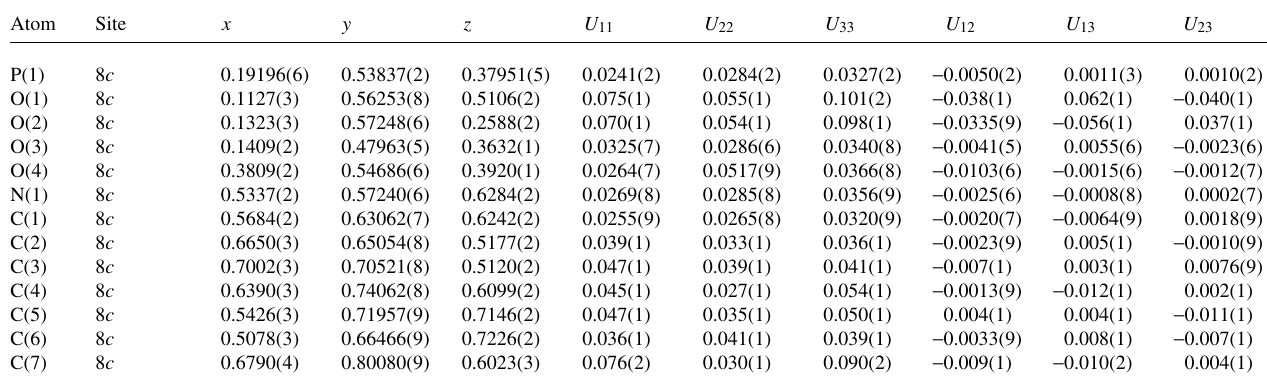
Table 3. Atomic coordinates and displacement parameters (in Å 2 )